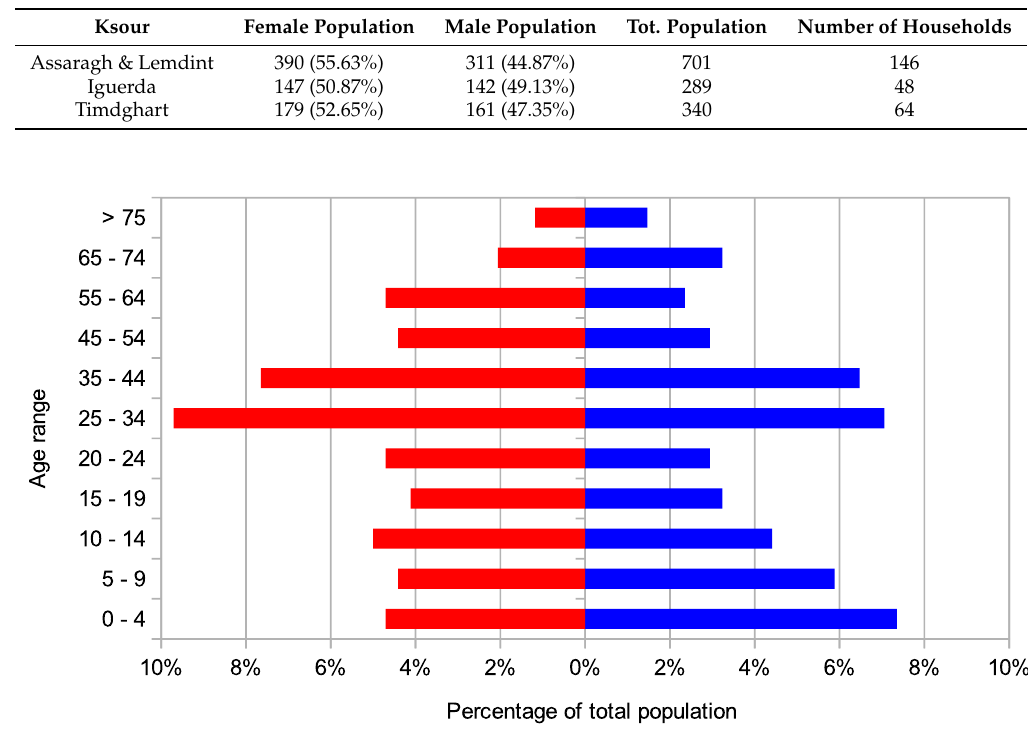
Figure 15. Demographic pyramid for Assaragh and Lemdint (RGPH 2014 [64]); total population 701 inhabitants. Left (red) the female population, right (blue) the male